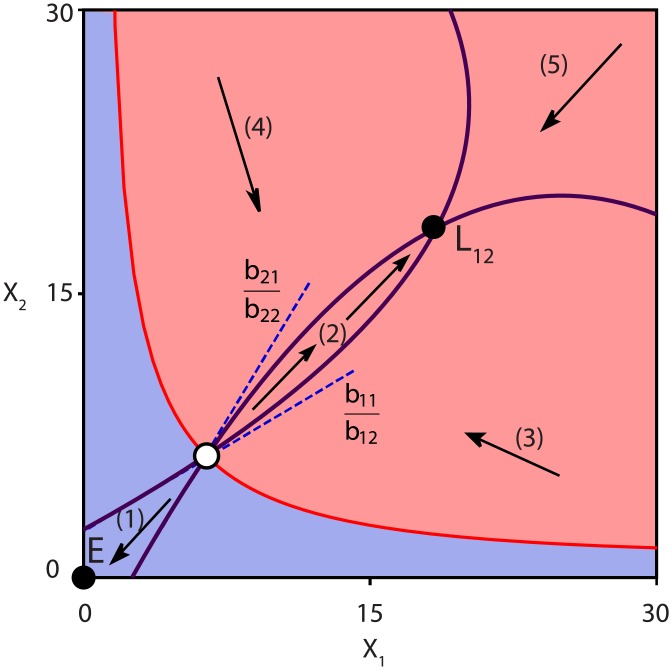
Zoom of Fig 3(b), using the same notation.The blue dashed lines are the linear approximations of the nullclines and need to intersect in order to have bistability. The regions (1)-(5) are discussed in the text. The blue and red areas correspond to the basins of attraction of each steady state.